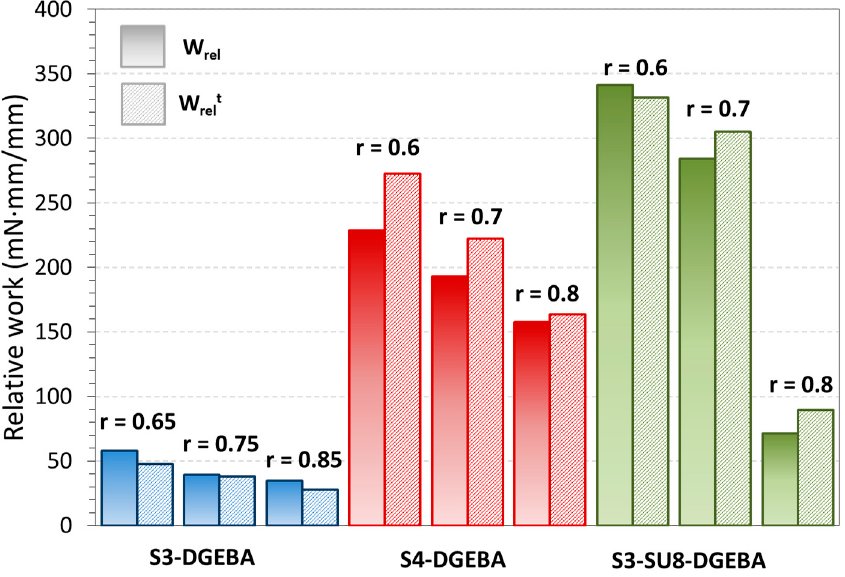
relt and experimental W rel for all the formulations of